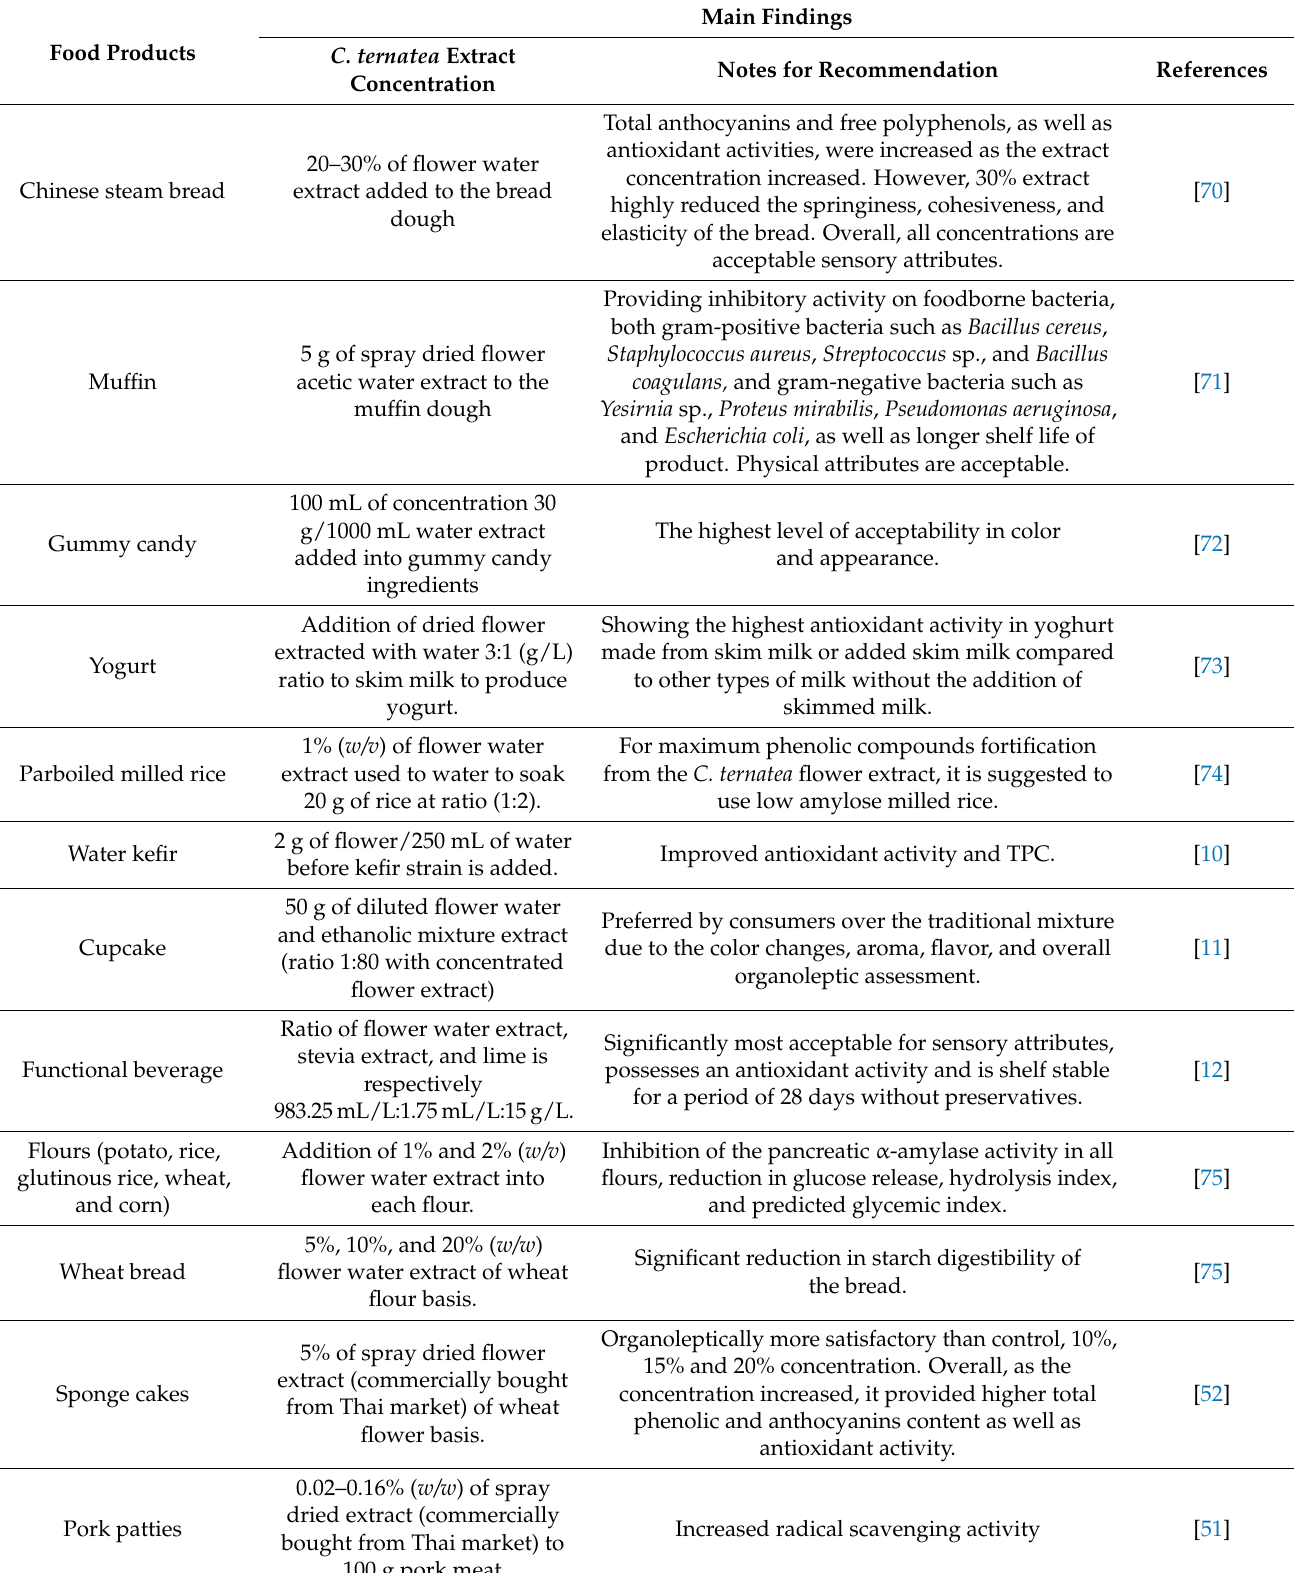
Table 4. Application of C. ternatea flower in food